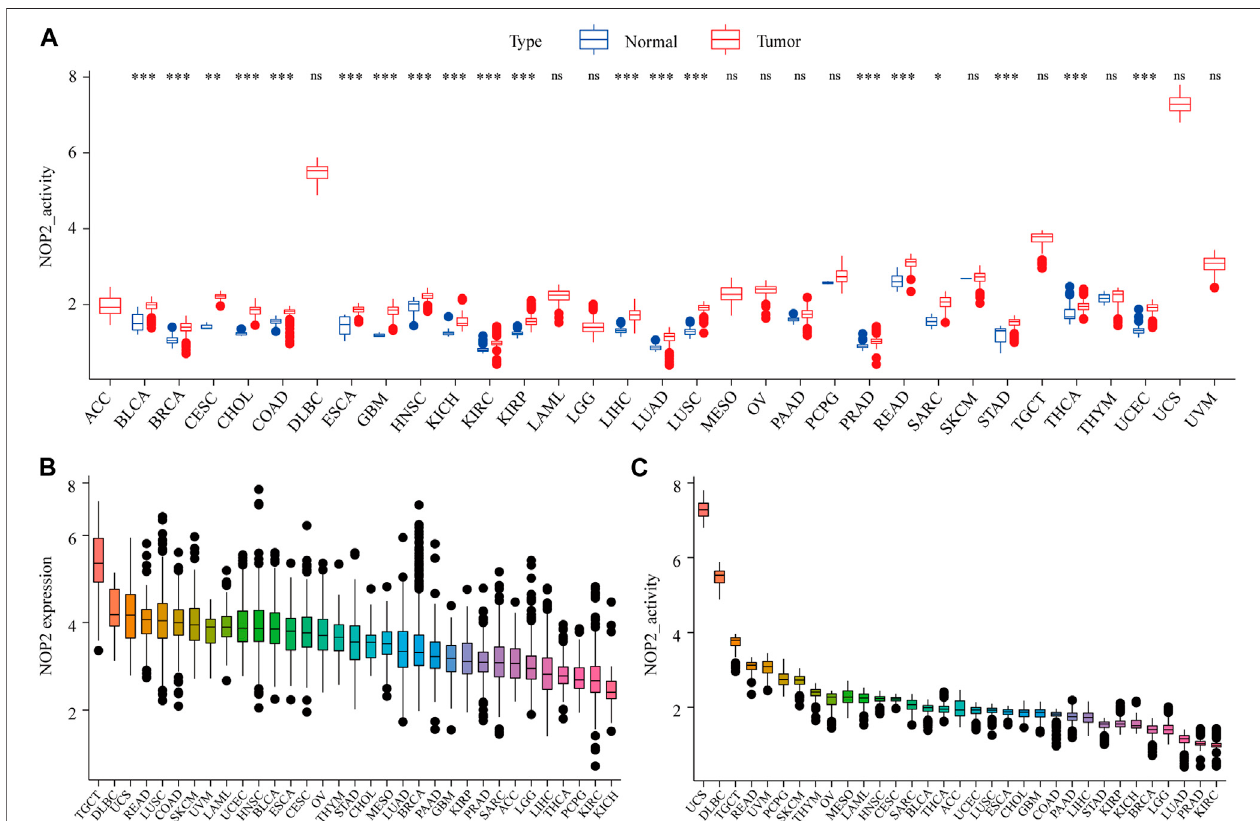
FIGURE2| GenerationandinvestigationofNOP2activityin33humancancers. (A) DifferentialactivityanalysisbetweenthetumorandnormalgroupsofNOP2; (B) mean expression of NOP2 in 33 cancers (from high to low); and (C) mean activity of NOP2 in 33 cancers (from high to low) (* p < 0.05; ** p < 0.01; and *** p < 0.001; ns means no signi fi